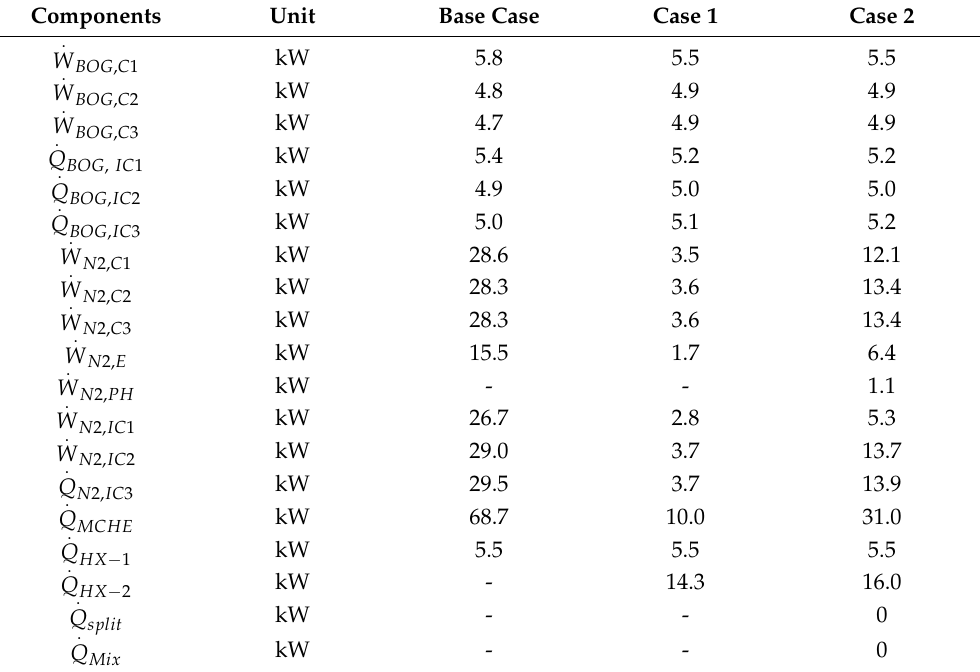
Table 8. Duty of components in the optimized